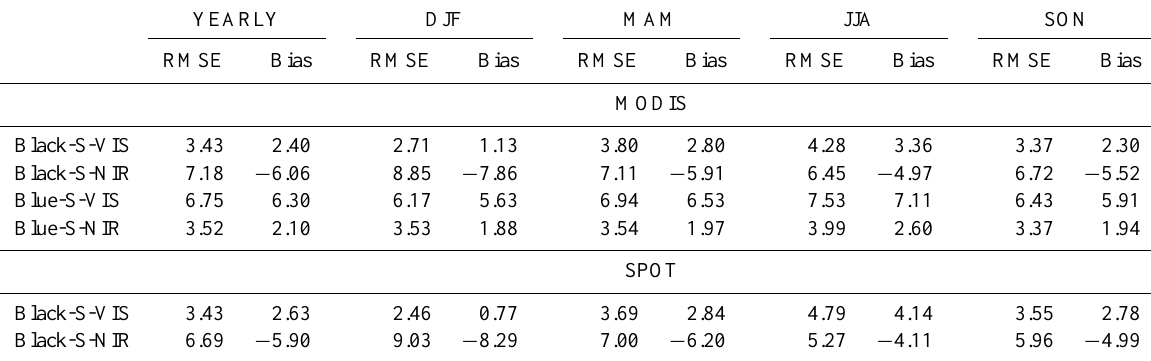
Table 3. Root mean square error (RMSE) and bias (scaled by 100) between the CNTL experiment and MODIS and SPOT black-sky (Black- S) visible (VIS) and near-infrared (NIR) albedo on the one hand and MODIS blue-sky (Blue-S) VIS and NIR albedo on the other hand on a yearly and seasonal timescale.